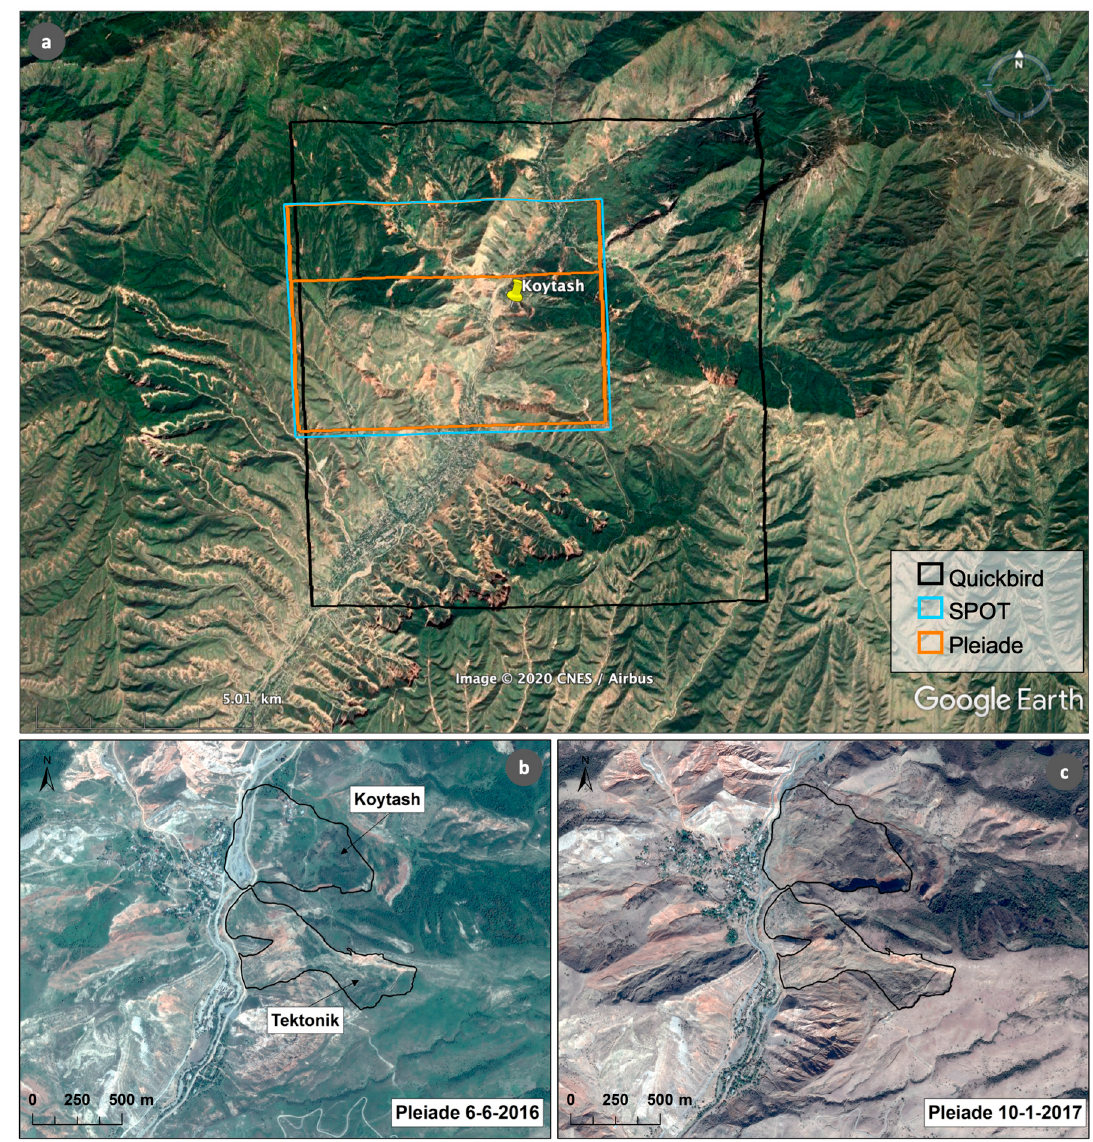
Figure 6. ( a ) Location of the main optical images over the Mailuu-Suu area in Google Earth. ( b ) Pleiades image of the 6th of June 2016 with the Koytash and Tektonik landslides (underlined in black). ( c ) Pleiades image of the 1st of October